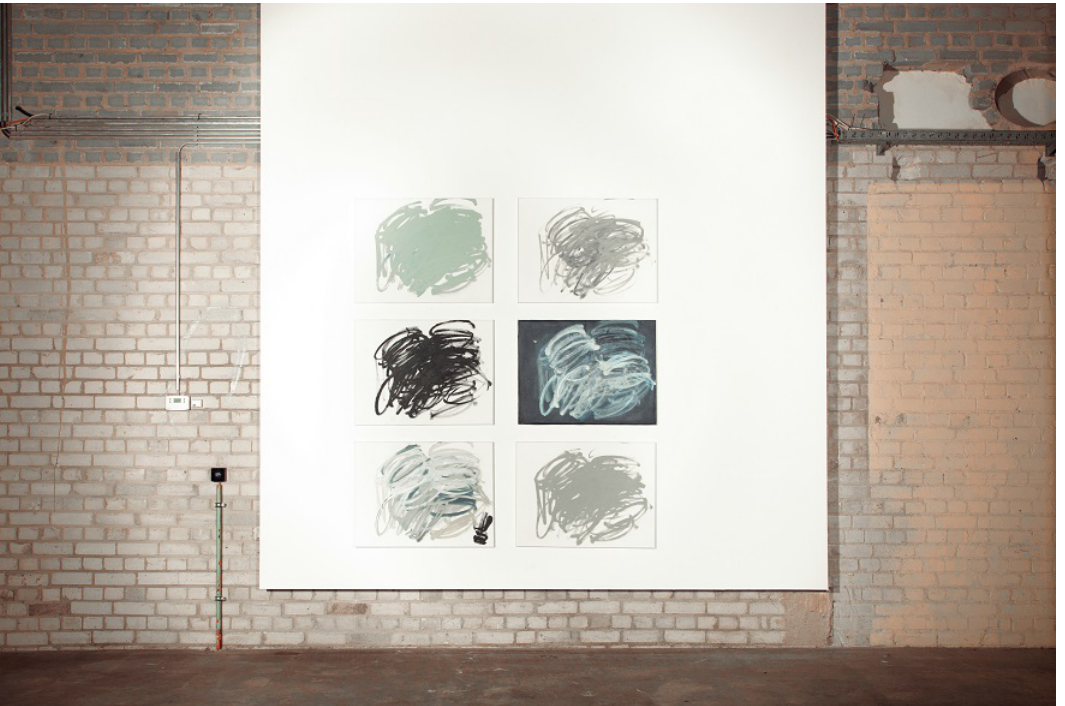
Figure A4. “Six Variations on Gestural Computer-Generated Brushstroke”, six robotic paintings. Acrylic on canvas. 60 cm × 80 each. 2016. Exhabition view: “Pinselstriche im digitalen Zeitalter Interdisziplinäre Forschung in Malerei & Robotik” at the Halle 14, Februar 2017 Spinnerei Leipzig. Liat Grayver, photo c (cid:13) Marcus Nebe.